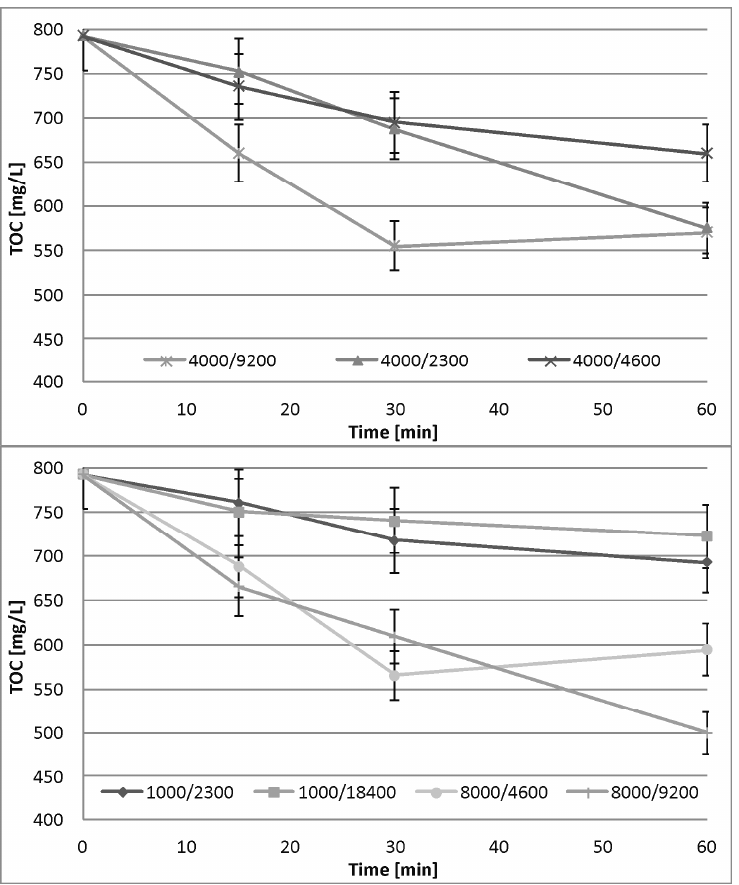
Figure 4. TOC removal during the Fe 0 /H 2 O 2 process after acidification pretreatment for selected Fe 0 /H 2 O 2 [mg/L] reagent doses.